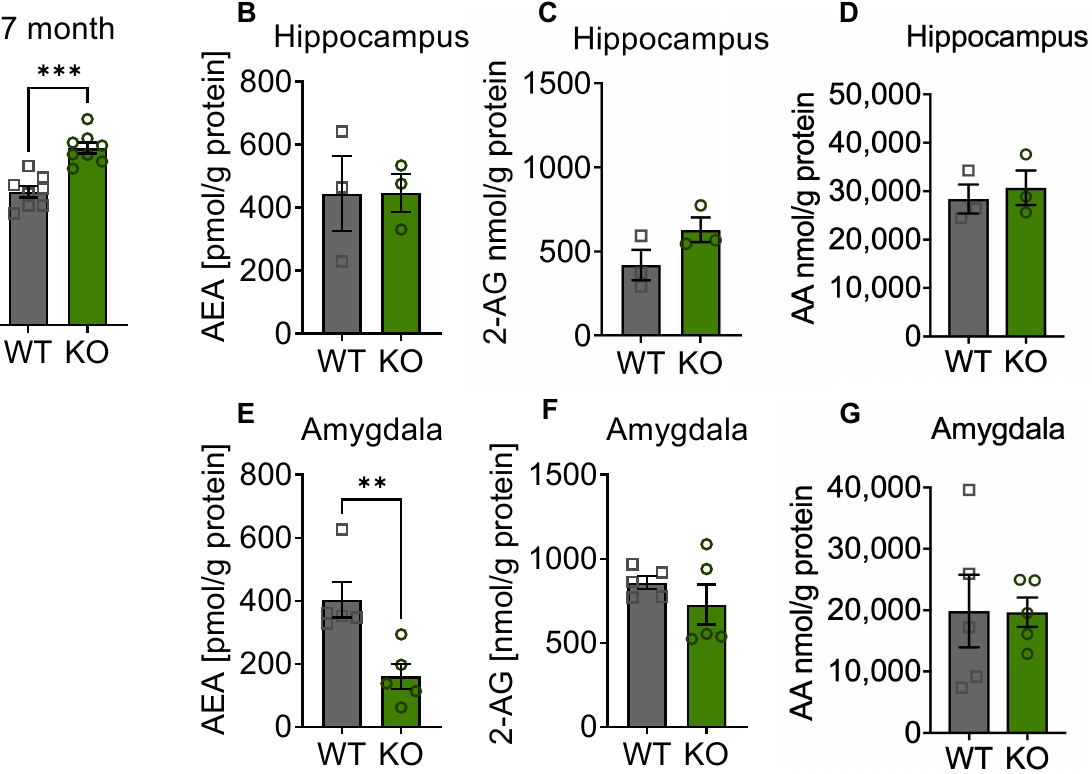
Figure 1. Altered endocannabinoid levels in the amygdala of mature p62 KO mice. ( A ) Body weight of p62 KO male mice aged 7 months was significantly increased compared to WT mice. ( B – D ) Endocannabinoid measurement in the hippocampus revealed no difference in level of 2-AG, AEA, or AA between genotypes. ( E ) AEA was significantly decreased in p62 KO mice in the amygdala. ( F , G ) Levels of 2-AG and AA in the amygdala were comparable between genotypes. Squares and circles represent single replicates. ** p < 0.01, *** p < 0.001 (unpaired t -test). WT male N = 8; KO male N =